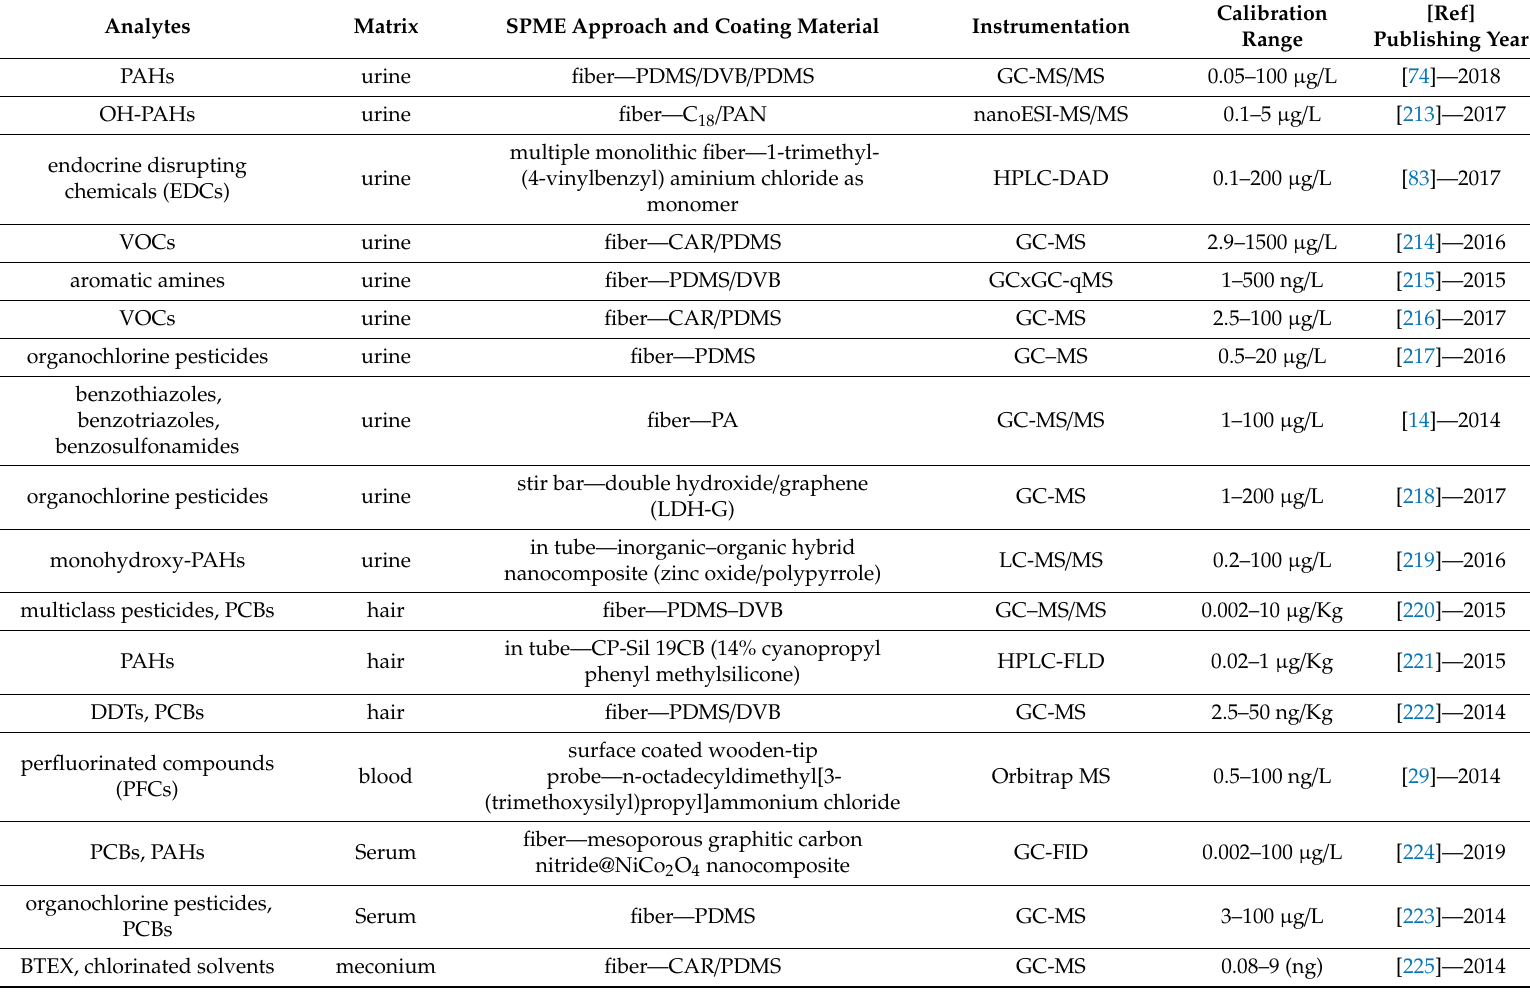
Table 3. Selected SPME applications in bio-clinical